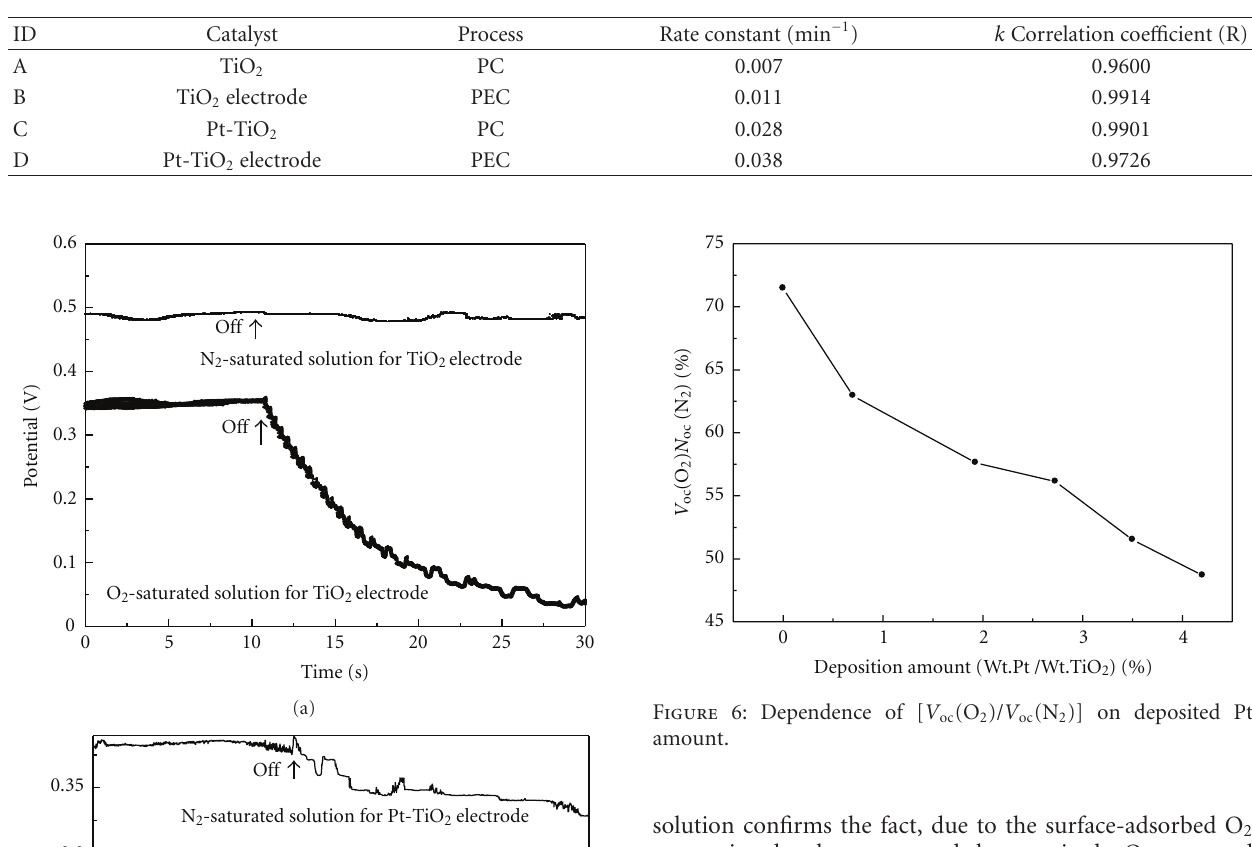
Table 1: The values of kinetic coe ffi cient k in four experiments with application of the first-order kinetic model.